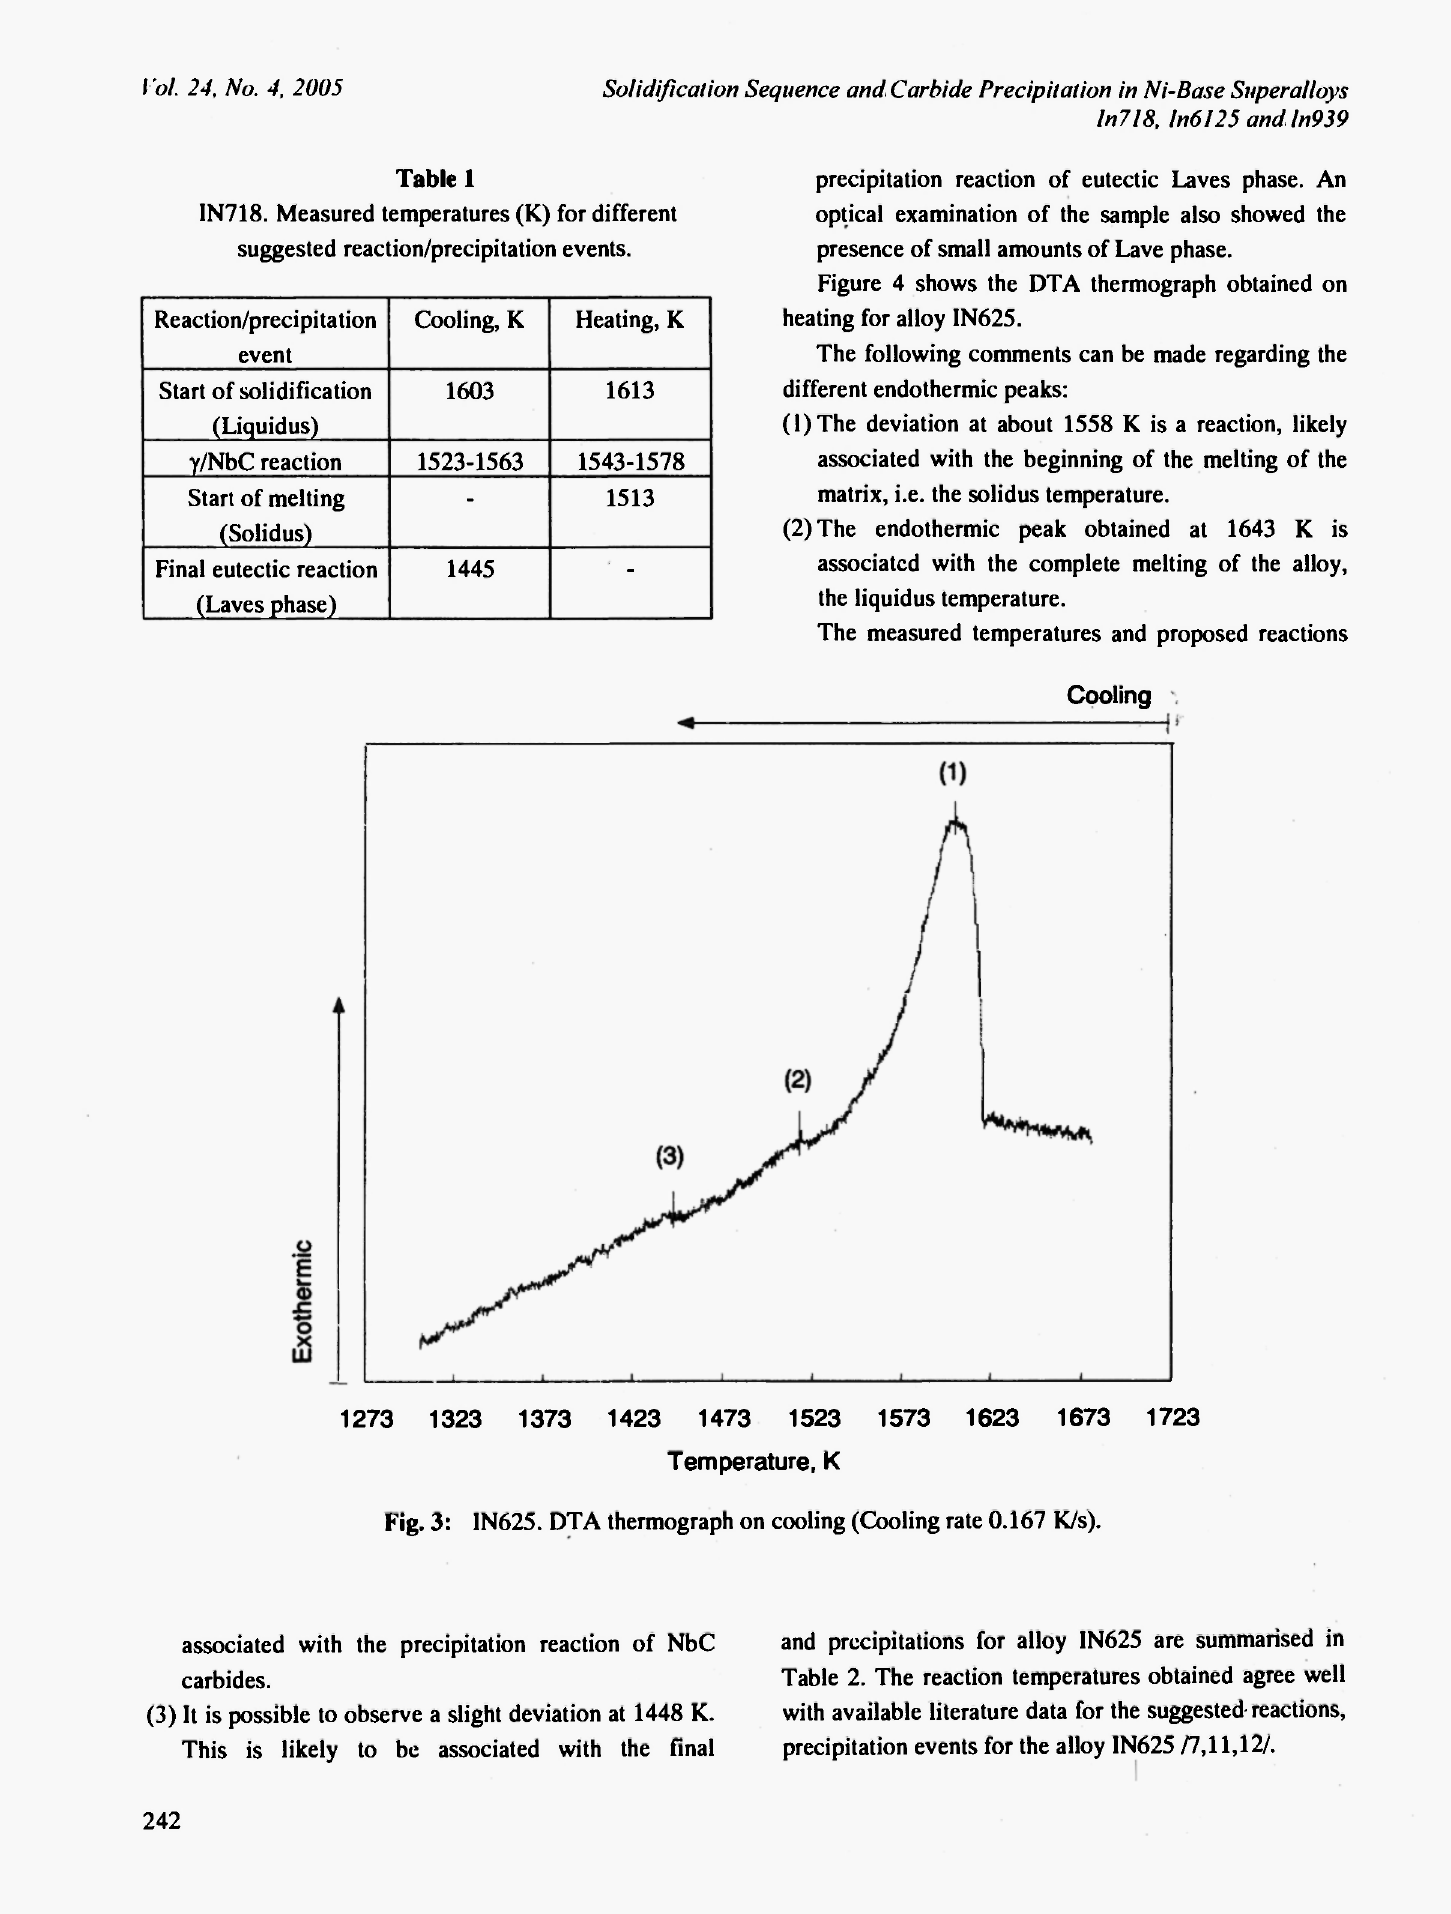
Fig. 3: IN625. DTA thermograph on cooling (Cooling rate 0.167